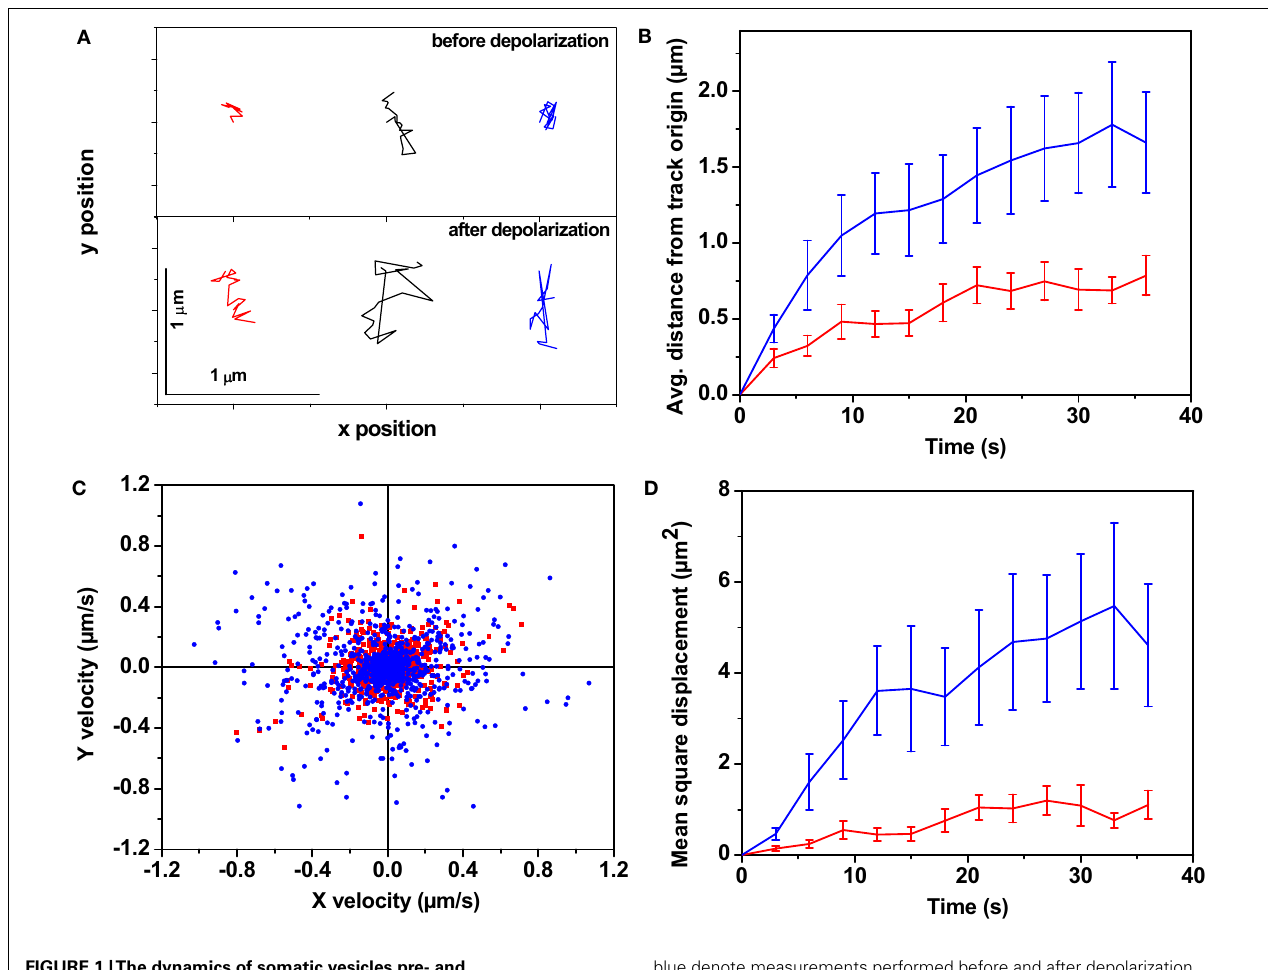
FIGURE 1 |The dynamics of somatic vesicles pre- and post-depolarization. Three photon excitation microscopy shows dynamics of somatic serotonergic vesicles (or unresolved vesicular clusters) in the cell body and in the processes before and after K + -induced depolarization. (A) Individual tracks of a few serotonin fluorescent spots before (top) and after (bottom) depolarization. In the following, red and